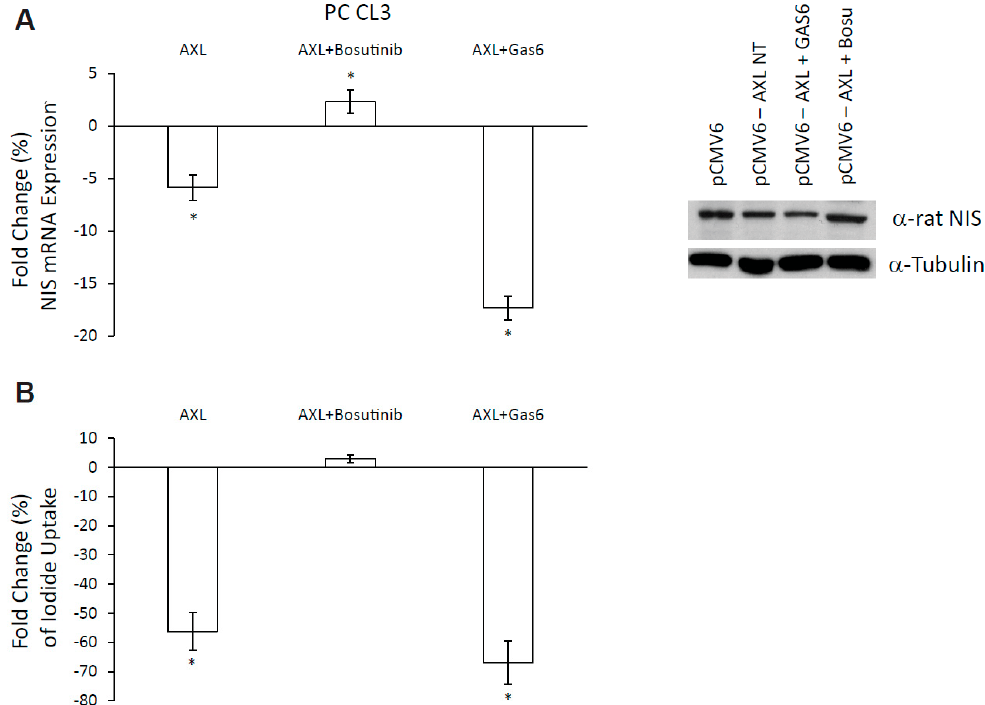
Figure 7. NIS modulation by AXL. ( A ) NIS mRNA expression and protein levels in PC CL3 cells transfected with pCMV6 empty vector, transfected with AXL and treated for 12 h with bosutinib (5 µ M) or GAS6 (100 ng / mL). mRNA expression levels expressed as fold change (%) over control (empty vector-transfected). * p < 0.05 vs. the relative empty vector transfected cells. ( B ) Iodide uptake levels expressed as fold change (%) over control (empty vector-transfected) in PC CL3 cells transfected with AXL and treated with bosutinib 12 h (5 µ M) or GAS6 (100 ng / mL). * p < 0.05 vs. the relative empty vector (pCMV6) transfected cells.